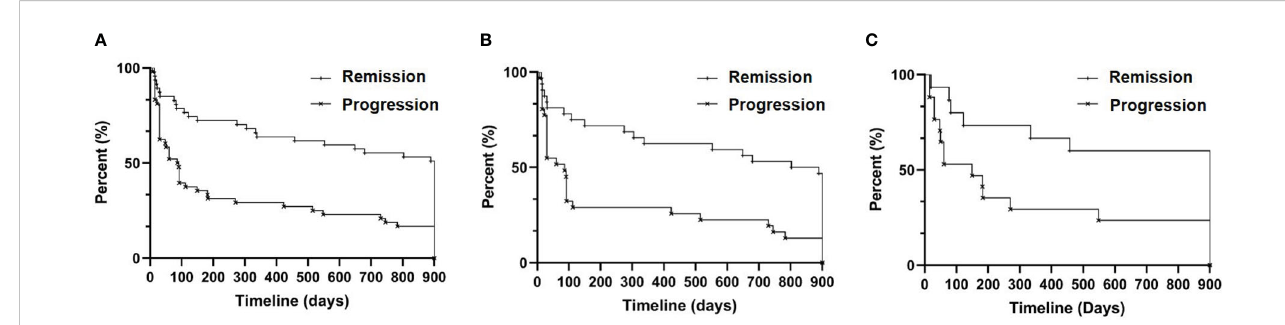
FIGURE 2 Progression-free survival analysis. (A) All patients (n=95, eight patients without documented drug dosage were excluded); (B) CHB patients (n=63, six patients without documented drug dosage were excluded); and (C) CTP grade A/B patients (n=32, two patients without documented drug names were excluded).